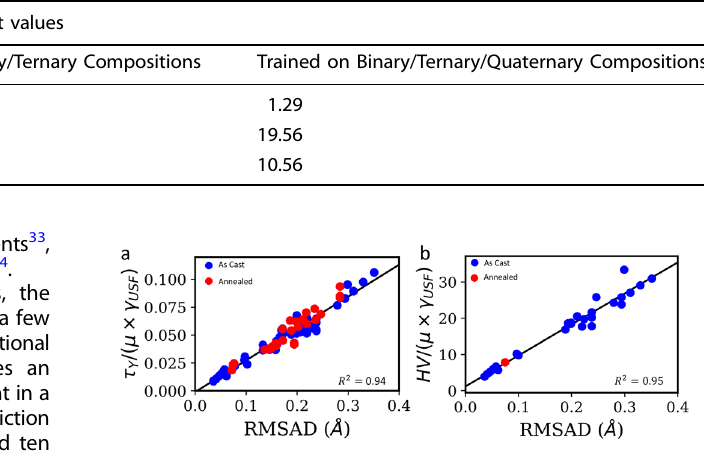
Fig. 5 Linear dependence of mechanical properties of RHEAs on the RMSAD parameter. a Normalized yield strength ( τ Y ) vs. RMSAD, and b Normalized Vicker ’ s hardness (HV) vs. RMSAD. The normal- ization factor is a product of the alloy ’ s isotropic shear modulus ( μ ) and USF energy ( γ USF ). The yield strength and hardens data are collected from the previous experimental measurements in the literature. The unit of the y axis is m 2 )/(GPa ∗ J) in ( b